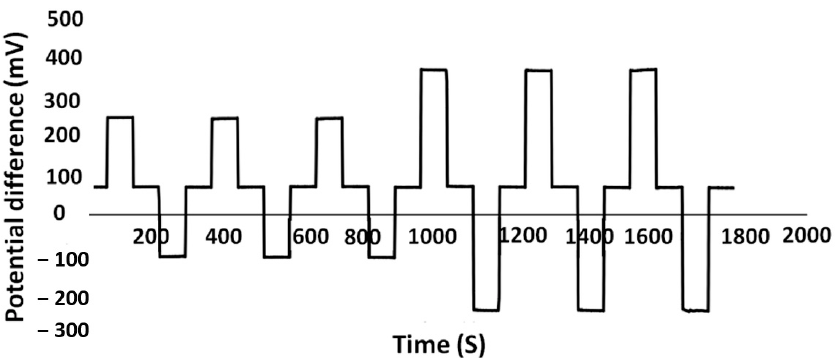
Table 6. Summary of the pH sensing performance of the developed TiN pH sensor. The data are extracted from Table 5.